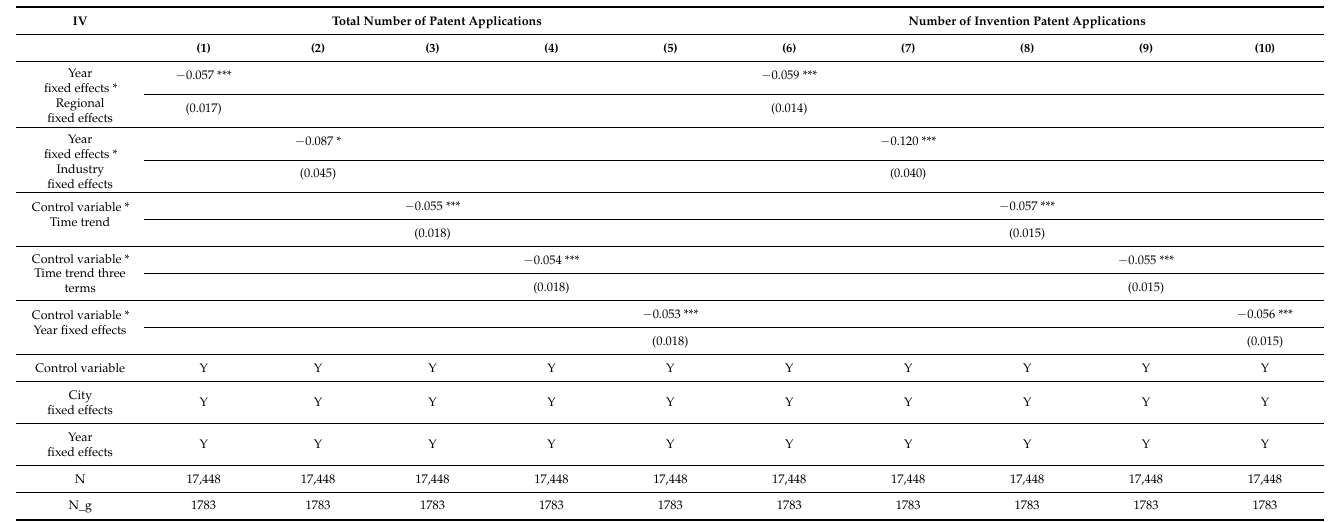
Table 4. Robustness test (1).